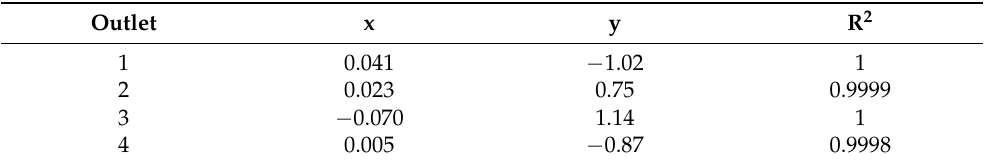
Table 2. Linearisation parameters to predict the average outlet temperatures in case of one heat pipe at position 3. Figure 13. Average temperature deviation for different heat pipe performances and positions.